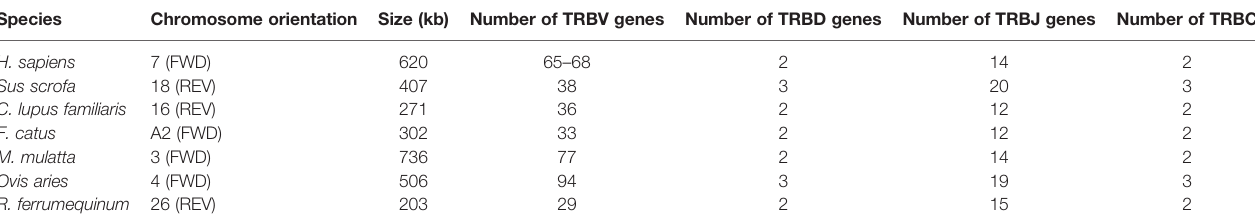
TABLE 3 | Statistical analysis of TRB loci in humans ( Homo sapiens ), mice ( Mus musculus ), dogs ( Canis lupus familiaris ), cats ( Felis catus ), rhesus monkeys ( Macaca mulatta ), rabbits ( Oryctolagus cuniculus ), and bats ( Rhinolophus ferrumequinum ). Species Chromosome orientation Size (kb) Number of TRBV genes Number of TRBD genes Number of TRBJ genes Number of TRBC H.